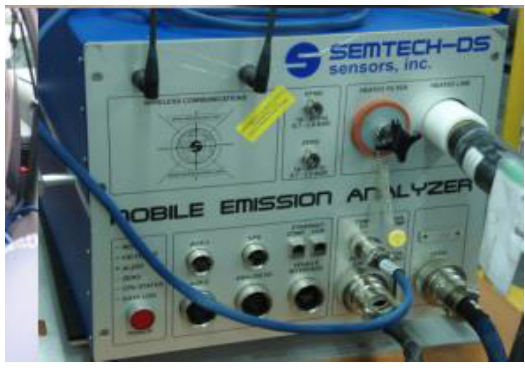
Fig. 1. Example of a PEMS device – SEMTECH DS [17]